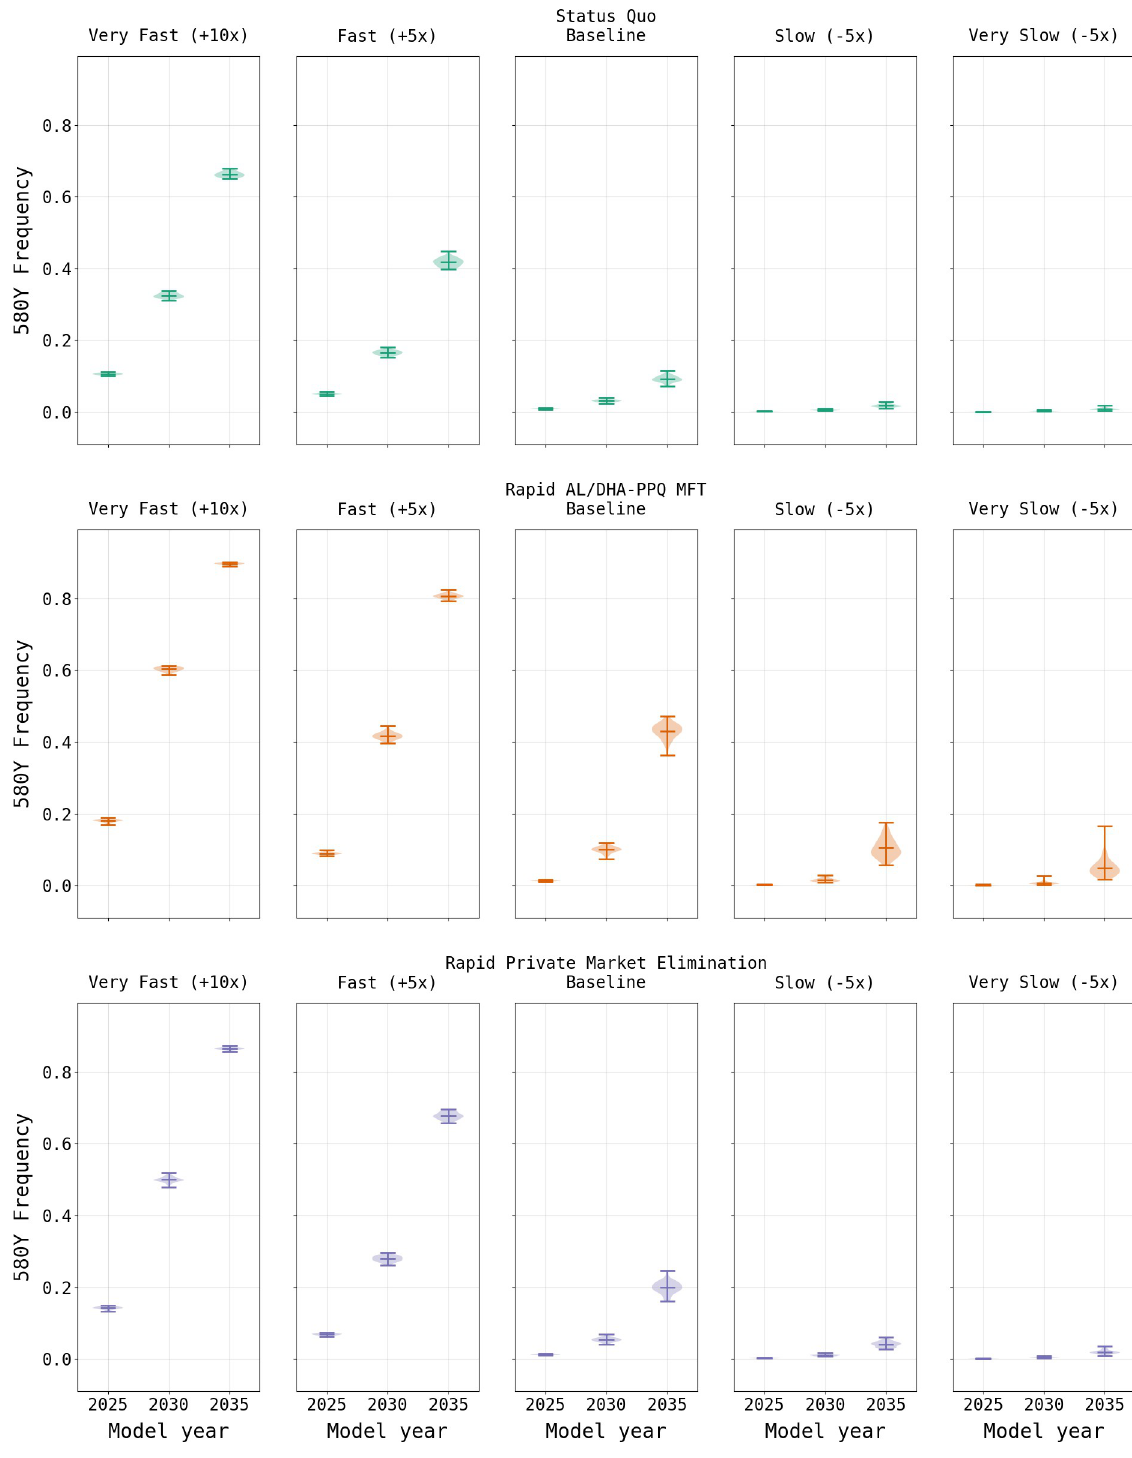
Fig 4. Effects of changes to the mutation rate on 580Y frequency. As expected, the frequency of 580Y is higher when the mutation rate increases to be 5x and 10x faster than the baseline (left two columns) and is lower than the baseline calibrated rate (center column) as the mutation rate decreases to be 5x and 10x slower than the baseline (right two